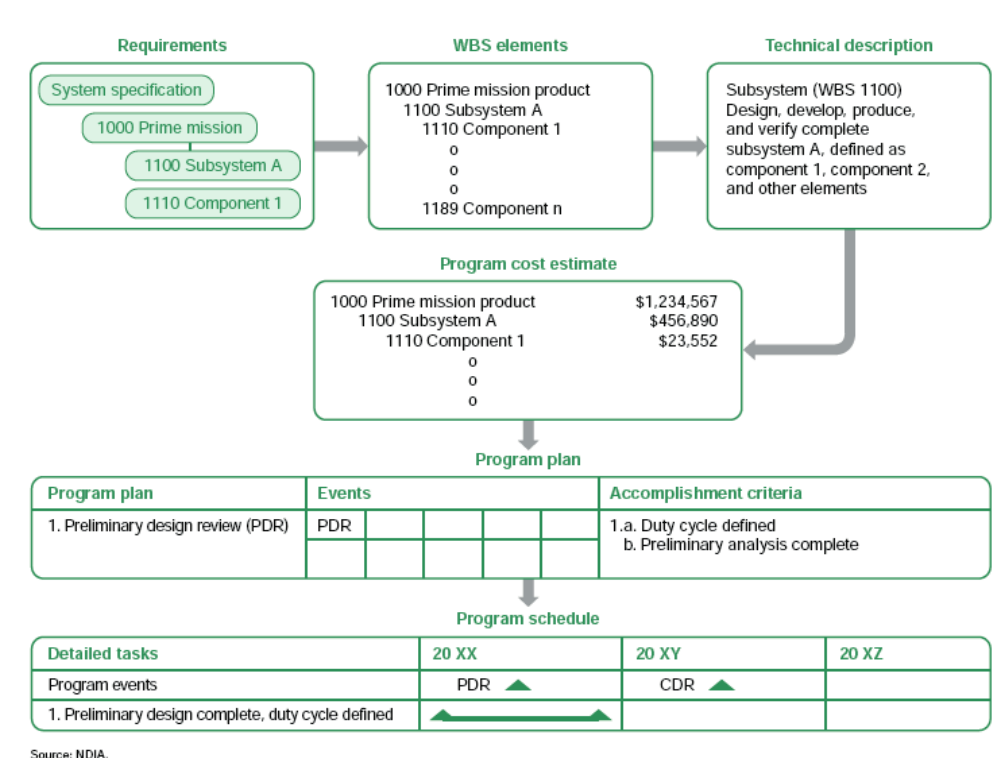
Fig. 16. WBS integration of cost, schedule and technical information (GAO 09- 3SP, 2009: 216; NDIA IPMD, 2018: